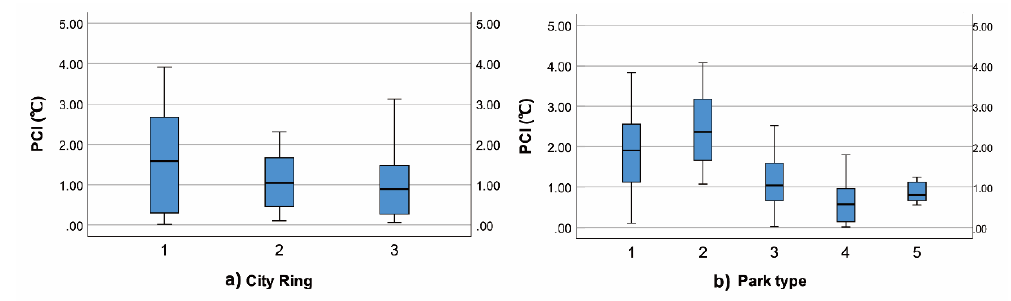
Figure 8. Analysis between PCI and location factor and park types (all 123 samples). ( a ) PCI and park location in three city rings; ( b ) PCI and five park types: 1-urban park; 2-theme park; 3-street park; 4-linear park; 5-urban square.